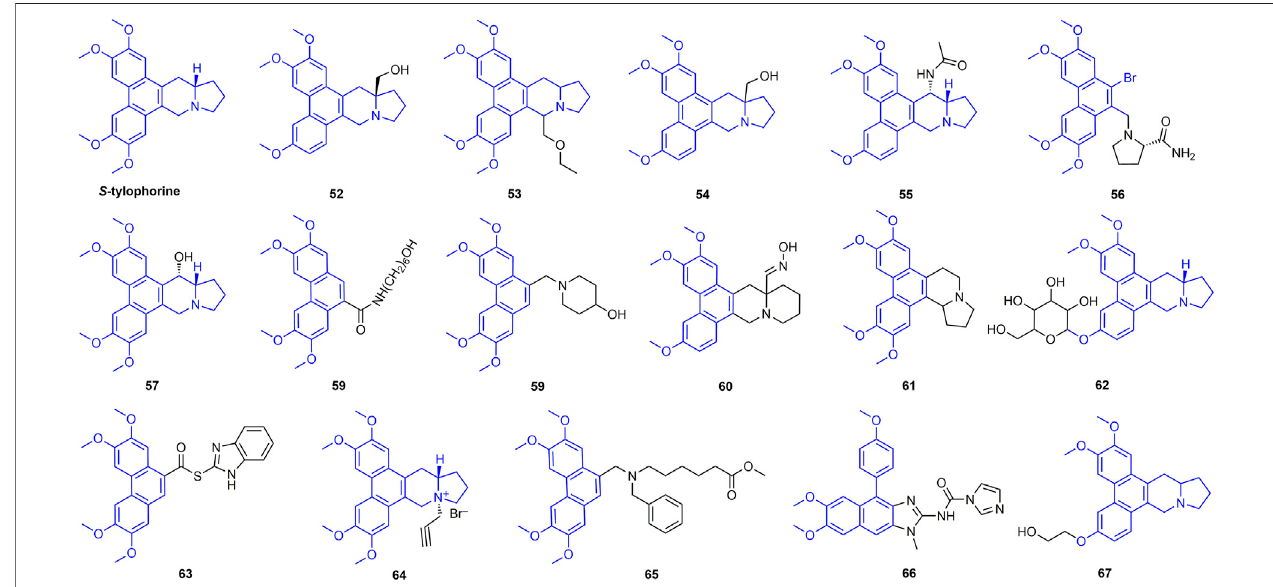
FIGURE 12 | Structures of representative tylophorine analogues in antiviral activities.